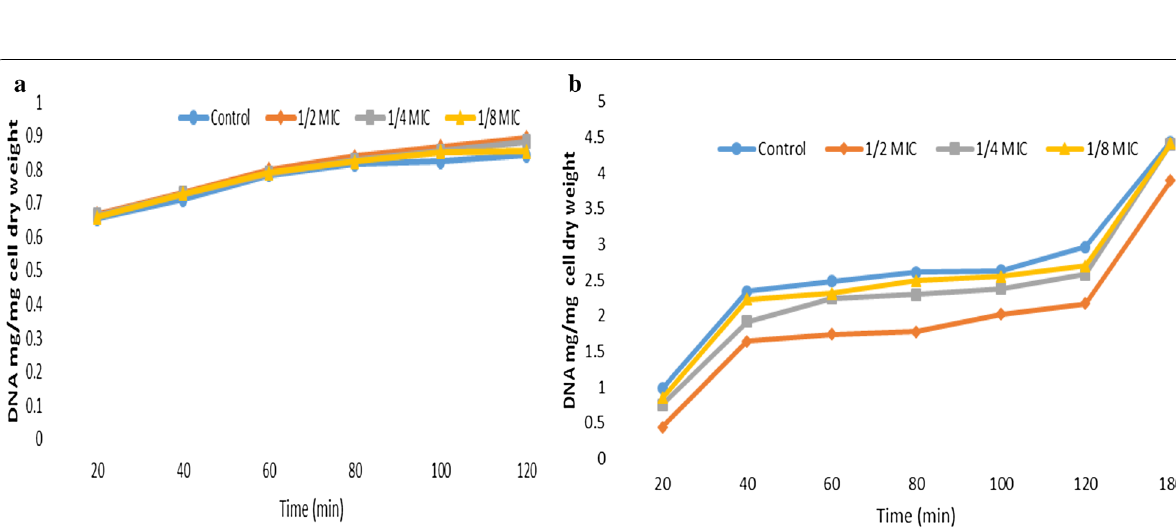
Fig. 5 Effect of different Citrus lemon leaves oil on the DNA biosynthesis in cells of P. aeruginosa ( a ), S. aureus ( b